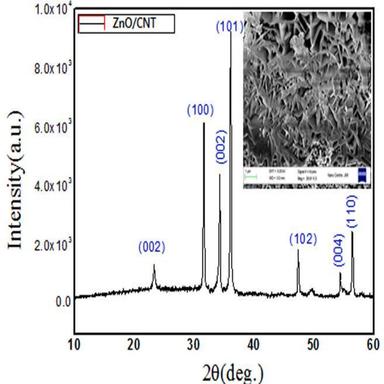
Schematic of(ZnO)0.90(CNT)0.10 thick film development via screen printing along with the inset of SEM image (ZnO)0.90(CNT)0.10 thick film.